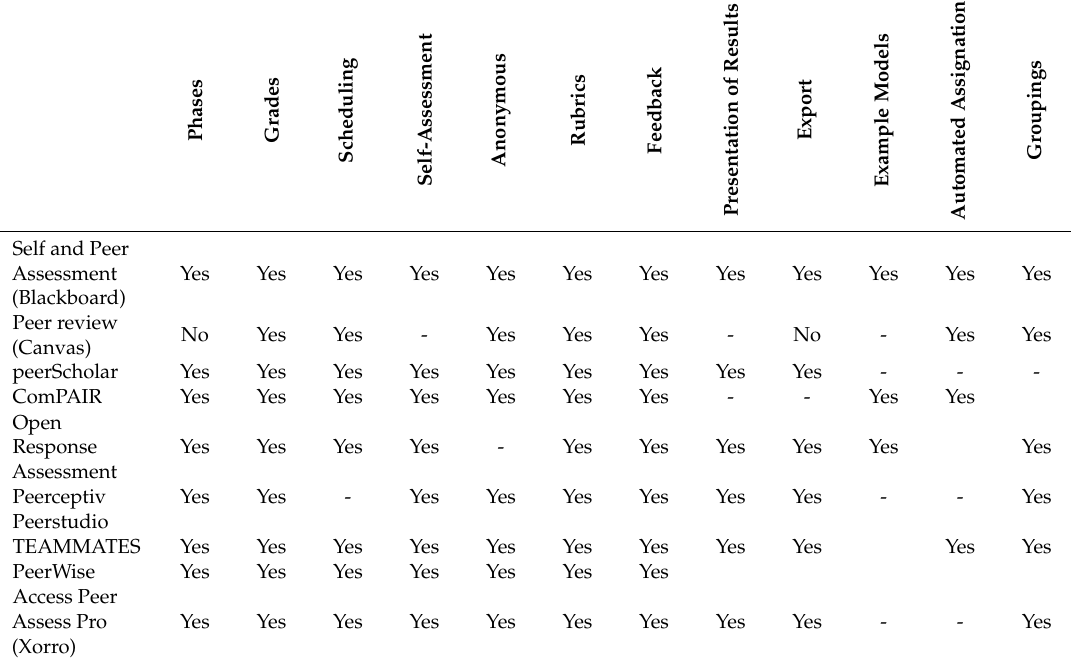
Table 1. Comparative table of the main software tools to support self- and peer assessment and their